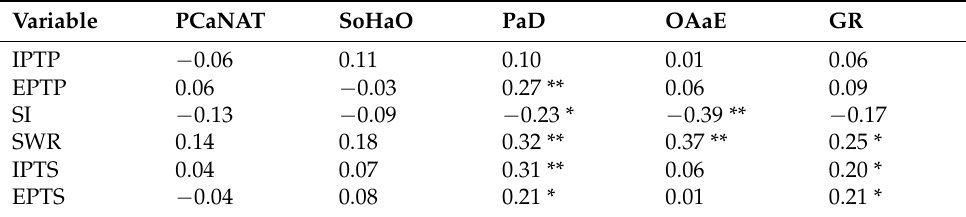
Table 3. R-Pearson Correaltions between Study Variables in the Subsample of Girls ( n = 101).